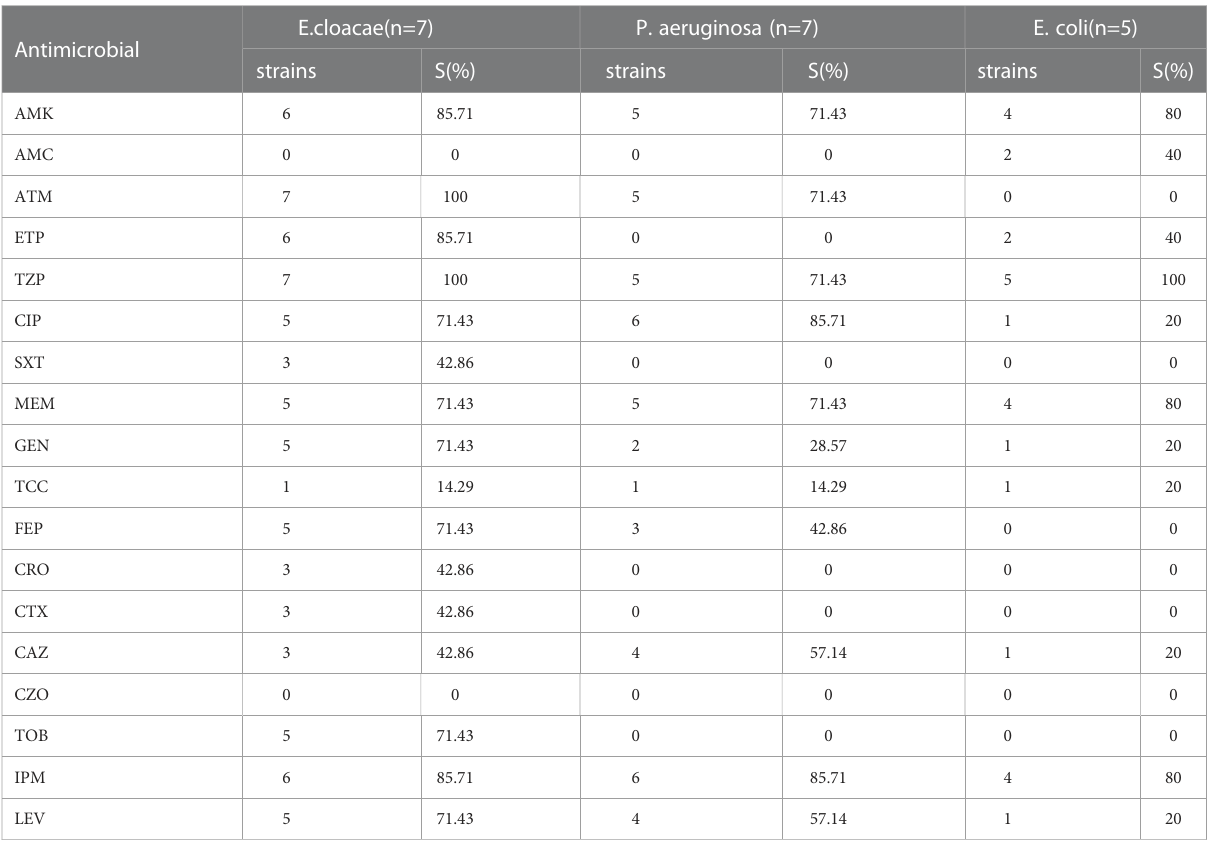
TABLE 5 Antimicrobial resistance of the main Gram-negative bacteria.